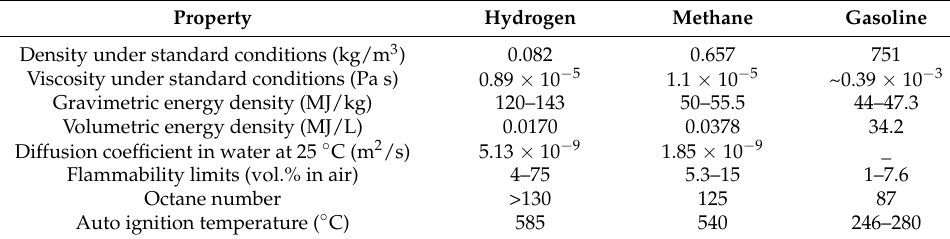
Table 2. Physiochemical properties of hydrogen, methane and gasoline.